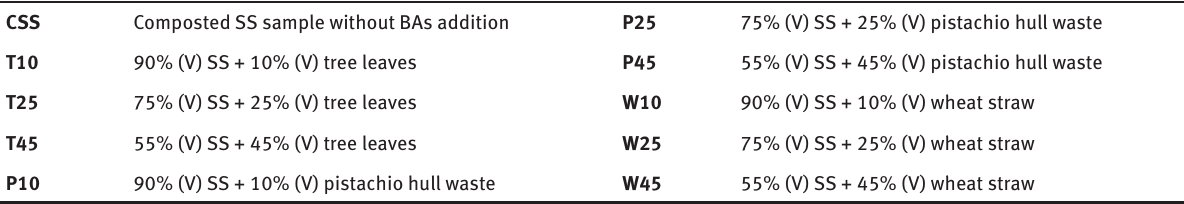
Table 3: Experimental design of SS compost production.